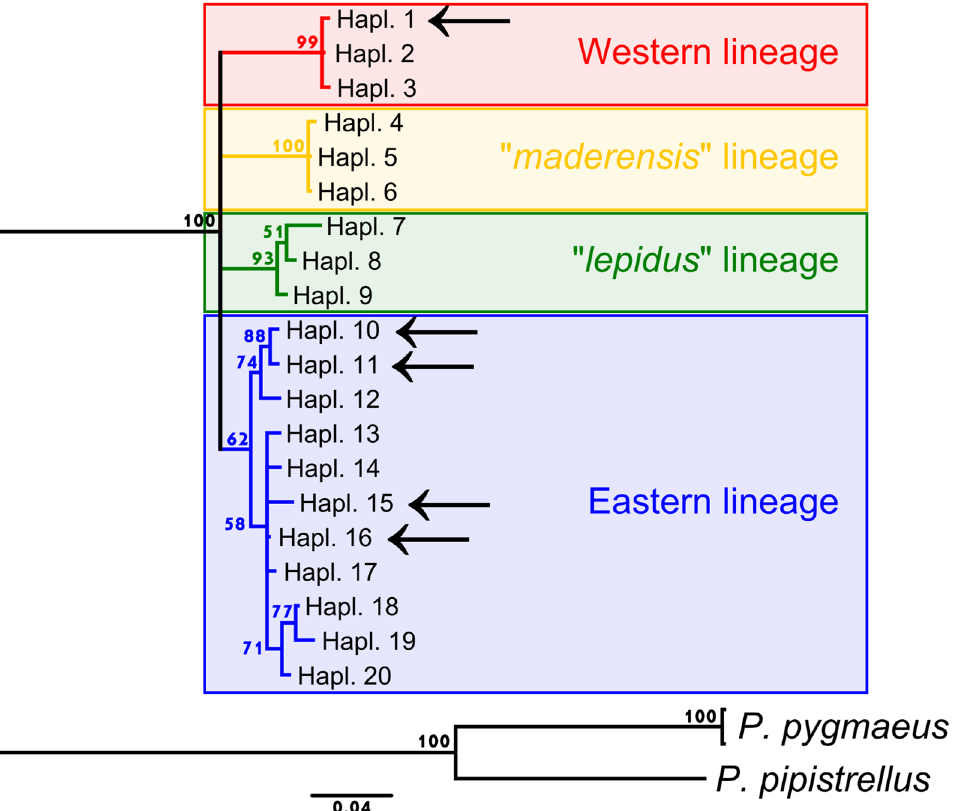
Fig 3. Phylogeny inferred by MrBayes from partial cyt- b sequences (467 bp). Coloured frames correspond to the four main mitochondrial lineages usually recognized within the P . kuhlii species complex. Posterior probabilities (PP) greater than 50% are indicated near the nodes. The position of the five cyt- b haplotypes observed in individuals also sequenced in this study for the COI gene are indicated with arrows. GenBank accession numbers for sequences used in this phylogeny can be found in S2 File.